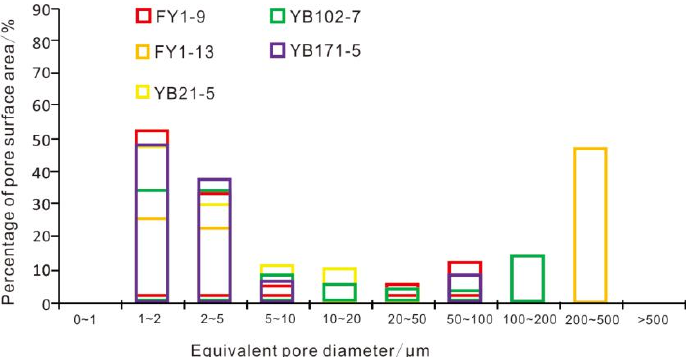
Figure 8. Percentage distribution of specific surface area of pores with different equivalent diameters in micron CT.